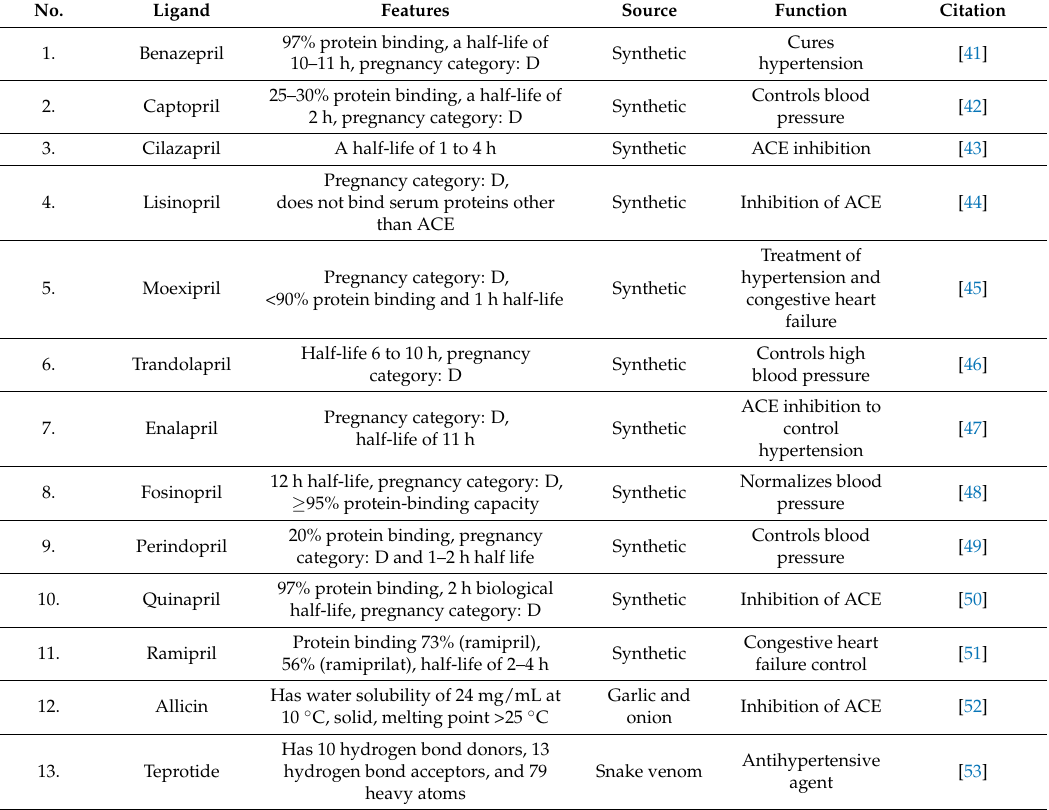
Table 2. Synthetic, herbal, and animal source inhibitors of angiotensin-converting enzyme (ACE). No. Ligand Features Source